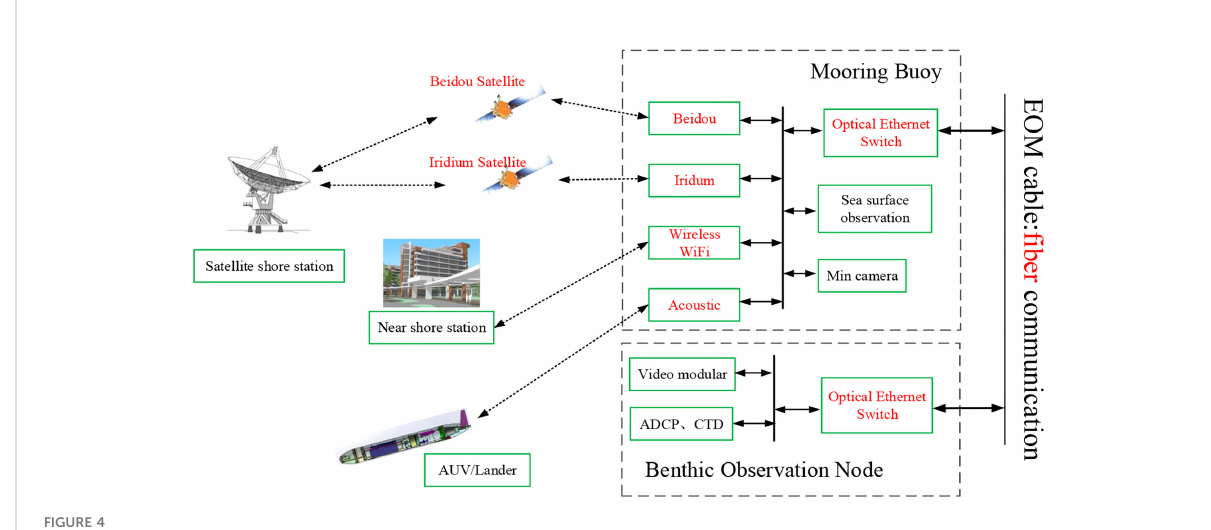
FIGURE 4 Concept design of communications